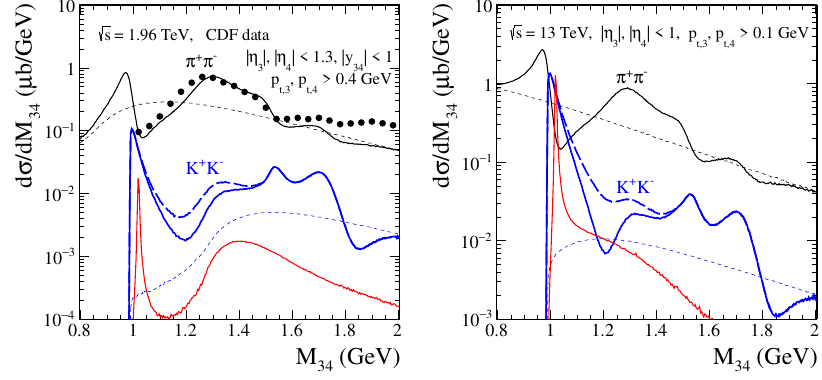
Figure 3. The invariant mass distributions for centrally produced π + π − (the black top lines) and K + K − (the blue bottom lines) pairs with the relevant experimental kinematical cuts specified in the legend. Theoretical results including both the non-resonant continuum and resonances are represented by the solid lines, respectively. The short-dashed lines represent the purely di ff ractive continuum term alone. The CDF experimental data from [1] in the left panel for the p ¯ p → p ¯ p π + π − reaction are presented. For = the pp → ppK + K − reaction the solid and long-dashed blue lines correspond to the results for φ f 0 (980) 0 and π/ 2 in the coupling constant g f + K − e i φ f 0(980) , respectively. The lower red line represents 0 (980) K the φ (1020) meson plus continuum photoproduction contribution. Absorption e ff ects were taken into account e ff ectively by the gap survival factors, (cid:104) S 2 (cid:105) = 0 . 1 for the purely di ff ractive contributions and (cid:104) S 2 (cid:105) = 0 . 9 for the photoproduction